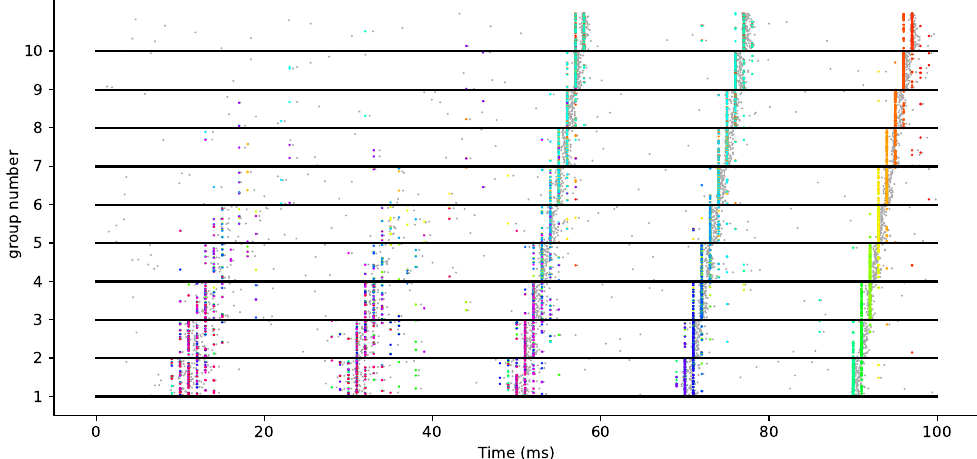
Figure 5. Detecting motifs using SPADE. We used the SPADE algorithm [130] by adapting their tutorial on the data generated in Figure 3. This allowed to label different precise spike motifs which are denoted by different colors. Spikes belonging to the same motif have the same